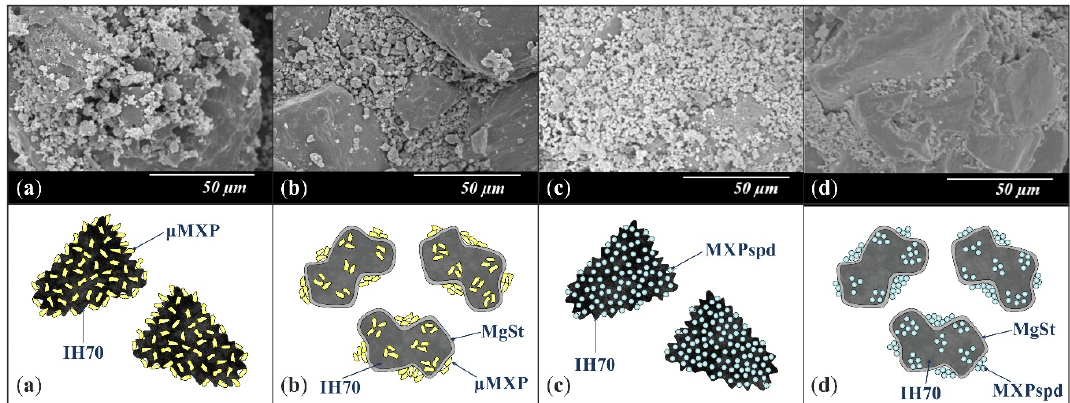
Figure 3. SEM recordings and schematic pictures of the carrier-based samples: ( a ) µMXP + IH70, ( b ) µMXP + IH70_MgSt, ( c ) MXPspd + IH70, and ( d ) MXPspd + IH70_MgSt.